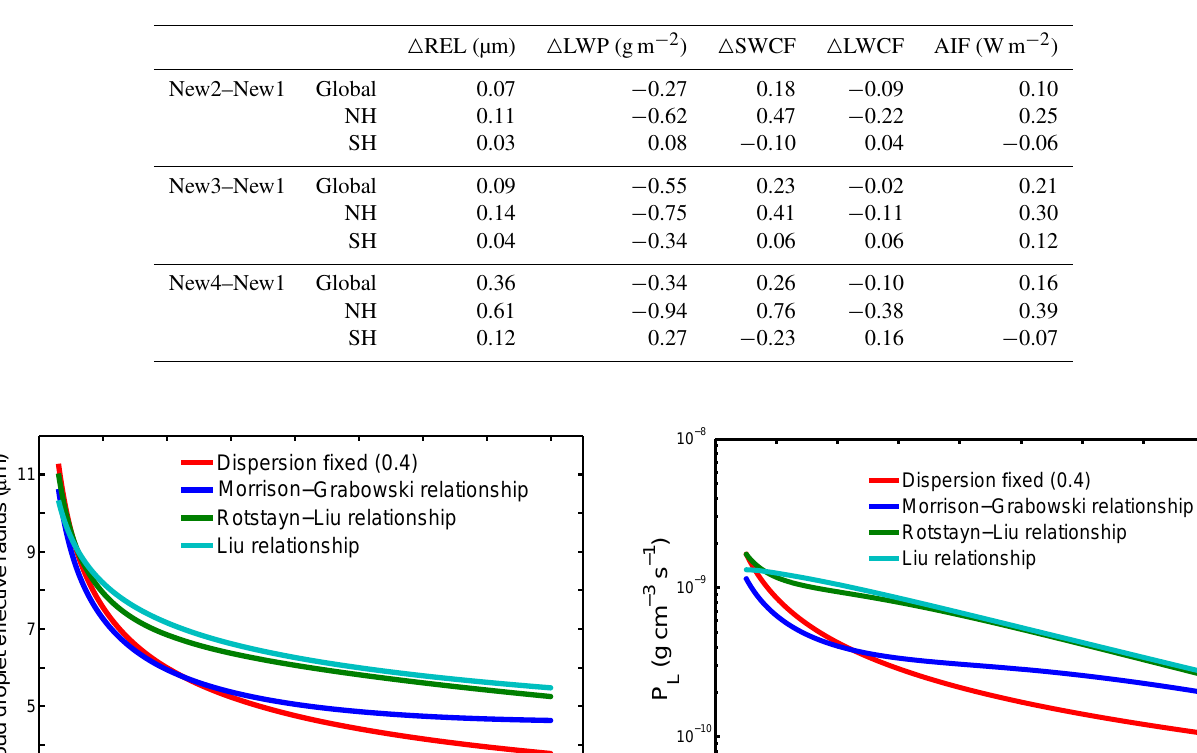
Table 7. Differences (New2–New1, New3–New1, and New4–New1) in global, Northern Hemisphere (NH), and Southern hemisphere (SH) annual mean changes of cloud-top effective radius ( (cid:52) REL), liquid water path ( (cid:52) LWP), shortwave cloud radiative forcing ( (cid:52) SWCF), and longwave cloud radiative forcing ( (cid:52) LWCF) between PD and PI, as well as aerosol indirect forcing (AIF).